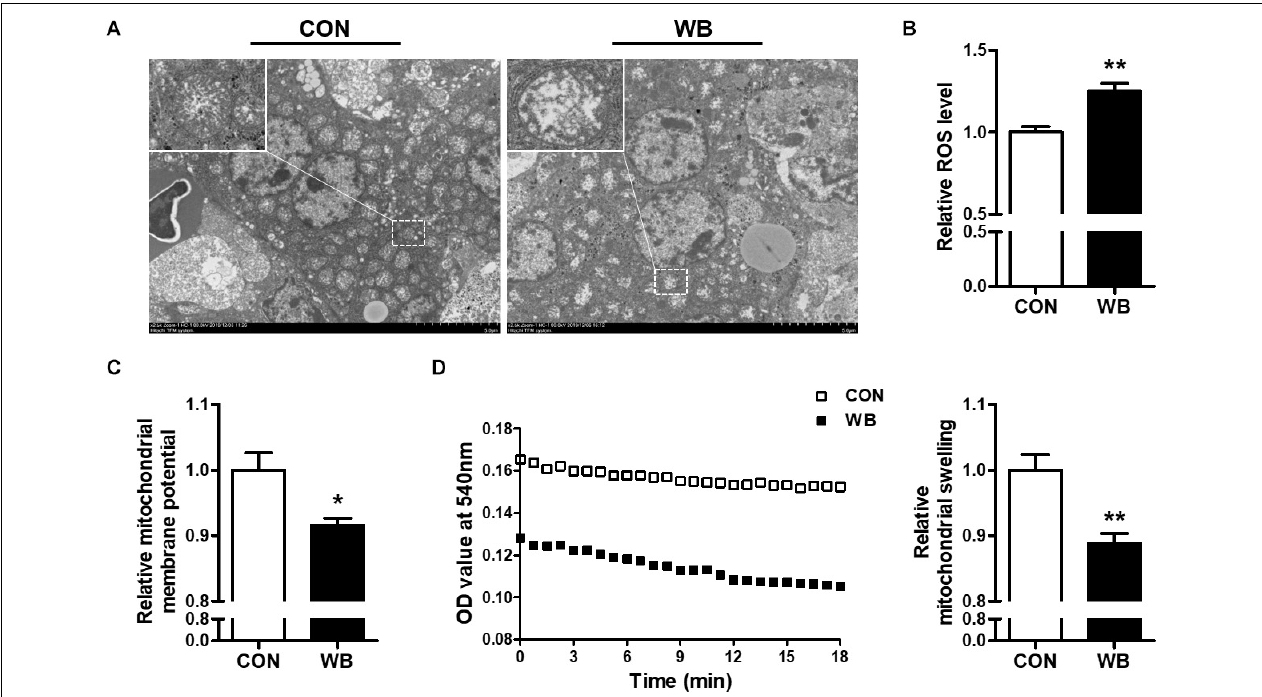
FIGURE 2 | Mitochondria morphology and mitochondrial function changes in the liver tissues of broiler chickens with normal (CON) and wooden breast (WB) pectoralis major muscle. (A) Representative transmission electron microscope images of liver. (B) Relative reactive oxygen species (ROS) level. (C) Relative mitochondrial membrane potential. (D) Relative mitochondrial swelling. Data are expressed as the mean ± SE ( n = 10). ** P < 0.01 and * P < 0.05.